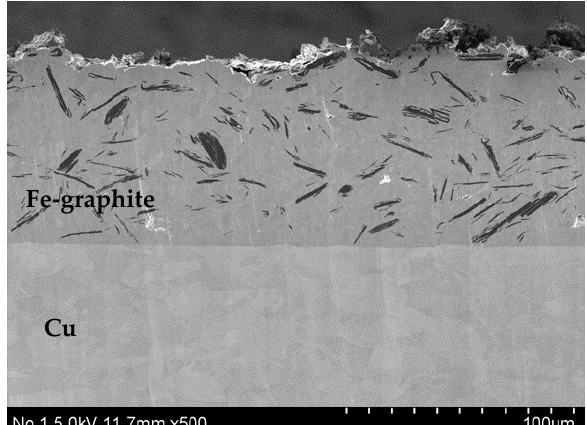
Fe-graphite Fe-graphite Fe-graphite